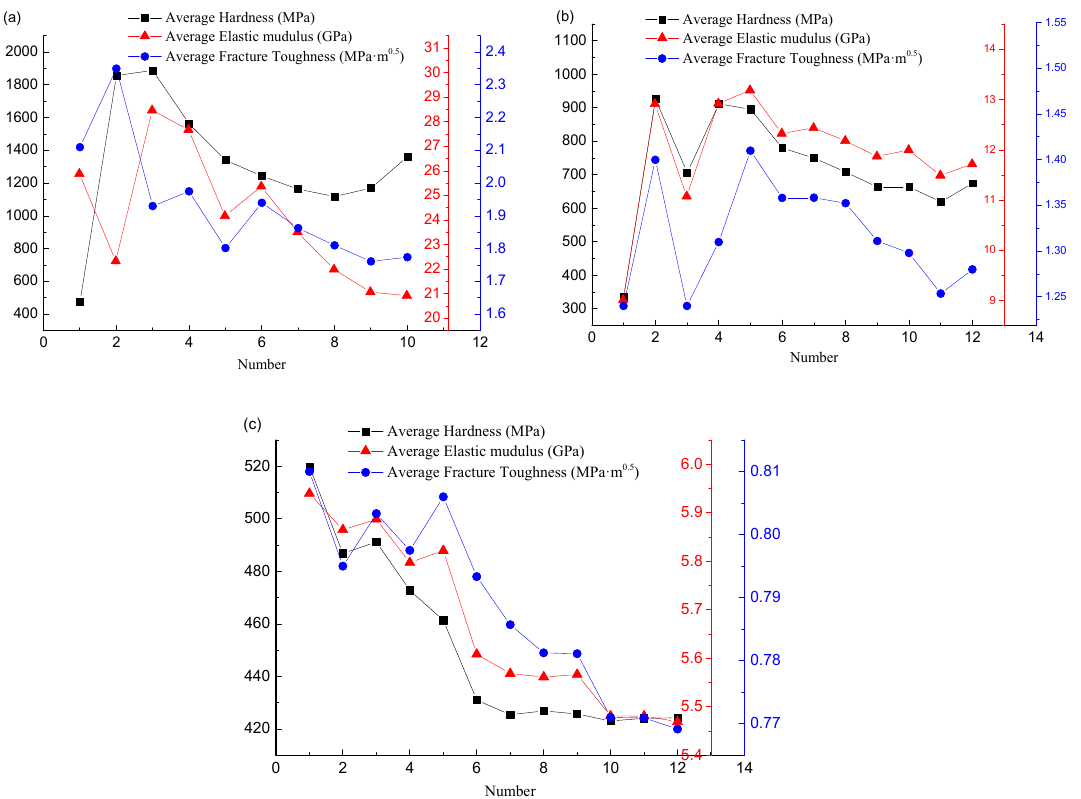
Figure 9. Relationship between the average values and experimental number of ( a ) shale, ( b ) mudstone and ( c ) coal.